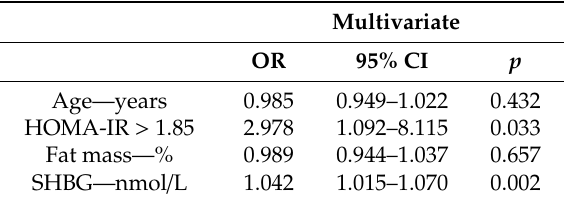
Table 3. Factors associated with the disagreement of testosterone results between IA and LC-MS / MS (defined by biases between IA and LC_MS / MS determinations that di ff er > 20% from the mean bias) in nondiabetic young men with obesity: multivariate regression models. Multivariate OR 95% CI